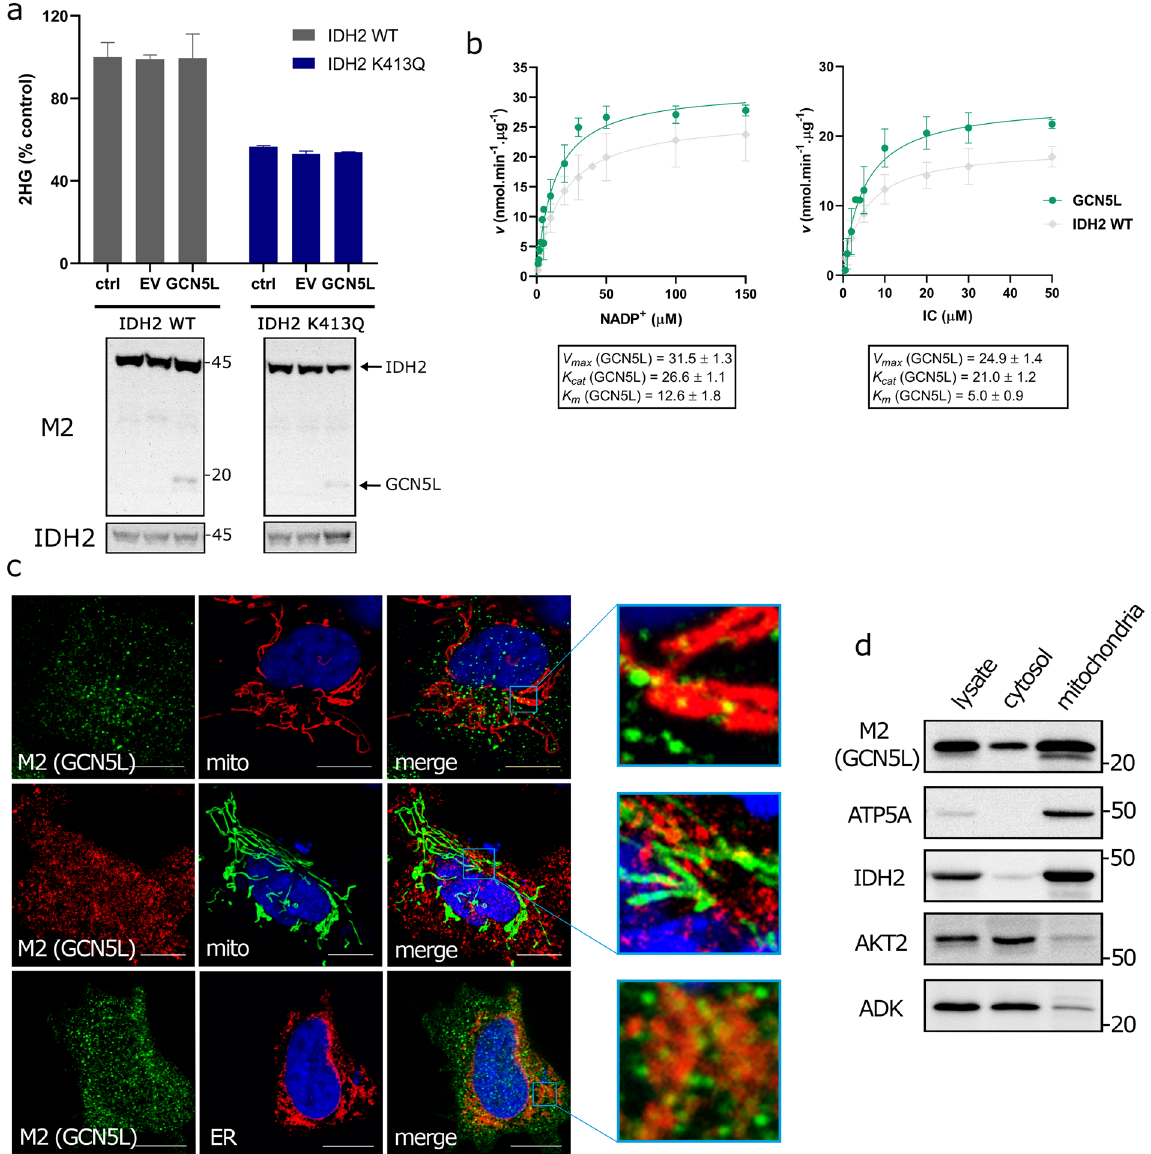
Figure 4. Role of GCN5L in acetylation of mitochondrial IDH2. (a) Cellular 2HG analysed by LC-MS from the control (ctrl), pcDNA3.1 (EV), and GCN5L-transfected cells overexpressing IDH2 WT or K413Q, respectively. N > 5. Underneath there is depicted western blot of the corresponding cell lysates of the analysed samples demonstrating transfection of GCN5L along with IDH2 variants (both detected by anti-M2 antibody). Western blot detecting IDH2 expression in stable cell lines. (b) Michaelis-Menten plots for NADP + -driven IDH2- mediated NADPH formation as dependent on concentrations of NADP + and isocitrate (IC) for purified protein from the IDH2-overexpressing SHSY5Y cells transfected with GCN5L. Box contains values of V max and K m . Unit of K cat for IDH2 WT/K413Q is s -1 ; data are expressed as mean ± s.e.m. (c) Confocal microscopy images of GCN5L transfected cells, GCN5L detected by primary anti-M2 antibody and labelled by secondary antibody conjugated with Alexa-Fluor 568 (red) or Alexa-Flour 488 (green); mitochondria-targeted GFP (mito-GFP, green); mitochondria-targeted Keima-Red (red), ER-targeted Tomato fluorescent protein (tdTomato-ER-3, red); overlay of the red and green channels (merge). The scale corresponds to 10 µ m. (d) Western blot depicting mitochondrial and cytosolic localization of GCN5L (detected by Flag-tag, M2), whole-cell lysate, cytosolic fraction, and mitochondrial